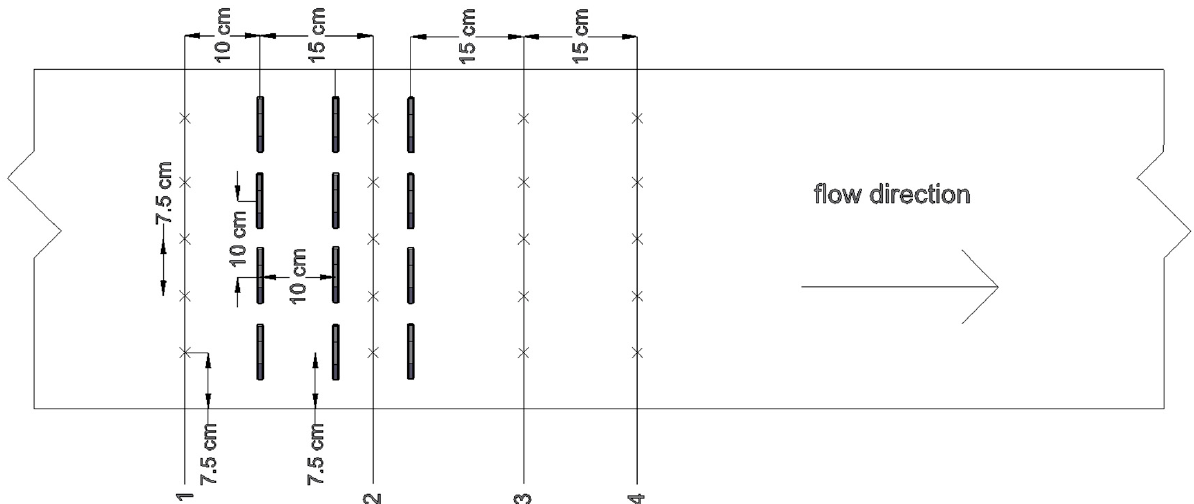
Figure 3. Plan sketch of vegetation elements and velocity profiles (X marks). The vertical lines (1, 2, 3, and 4) are the cross-sections.